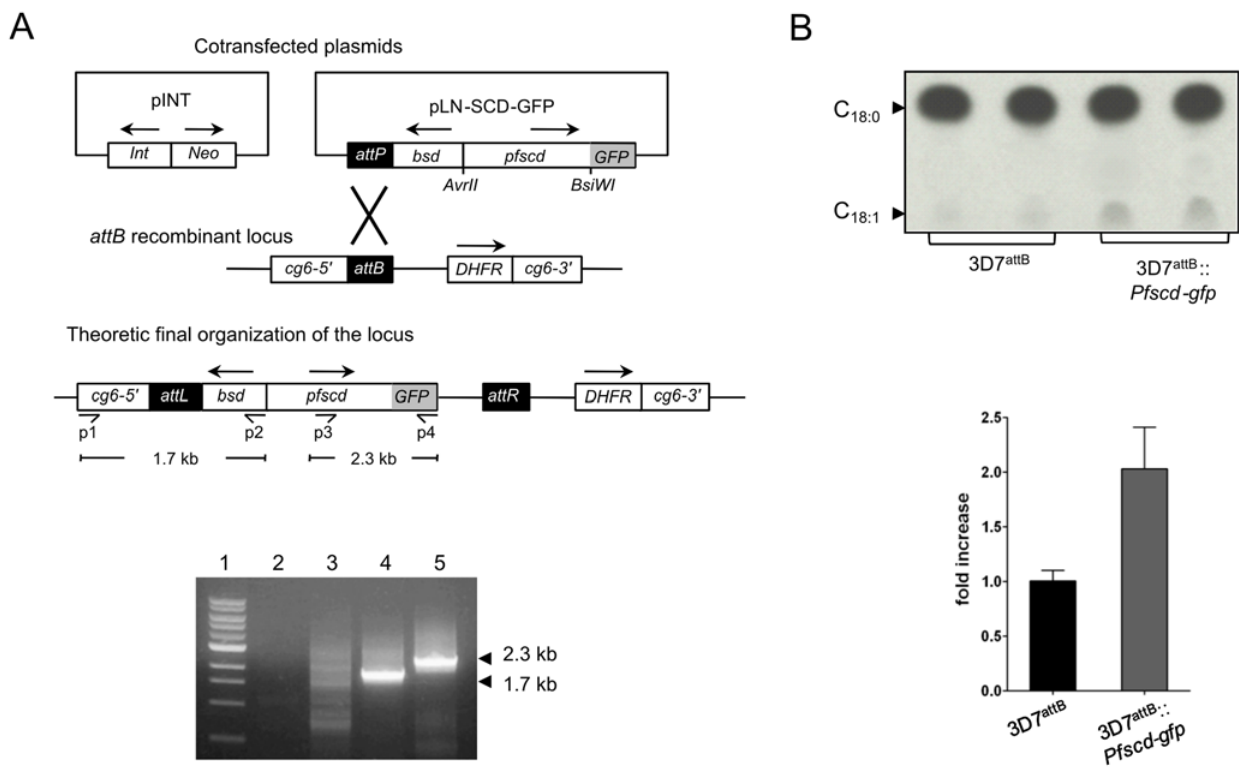
Figure 3. Stearic to oleic acid conversion in parasites overexpressing a Pfscd-gfp transgene. (A) Schematic diagram of the cotransfected plasmids, the recipient cg6-attB locus and the recombinant locus produced upon integration of the Pfscd-gfp cassette (upper panel). The lower panel represents integration of Pfscd-gfp into the cg6-attB locus of 3D7 attB :: Pfscd . Lane 1: 1 kb ladder. Lanes 2&4: integration of the blasticidin cassette into the locus was assayed by PCR using primers p1 and p2. Lanes 3&5: the presence of the complete Pfscd-gfp fusion was detected using primers p3 and p4. Lane 2&3: control 3D7 attB strain. Lane 4&5: 3D7 attB :: Pfscd-gfp line. (B) 3D7 attB and 3D7 attB :: Pfscd-gfp rings were labeled with 1 m Ci of [ 14 C]-stearic acid for 6 hrs at 37 u C. Following extraction, equal counts (40,000 cpm) were loaded on a 10% silver nitrate-impregnated TLC plate. FAMEs were resolved using petroleum ether/diethyl ether (17/3, v/v) and revealed after overnight exposure to a Kodak Biomax MR film. The upper panel shows the fatty acid profile of two independent samples of each strain. Oleic acid methyl esters were scraped from the TLC plate and counted. Results are expressed as a fold increase of oleic acid production (normalized to a value of one in the 3D7 attB strain). The data in the lower panel represent the means of 4 experiments with standard